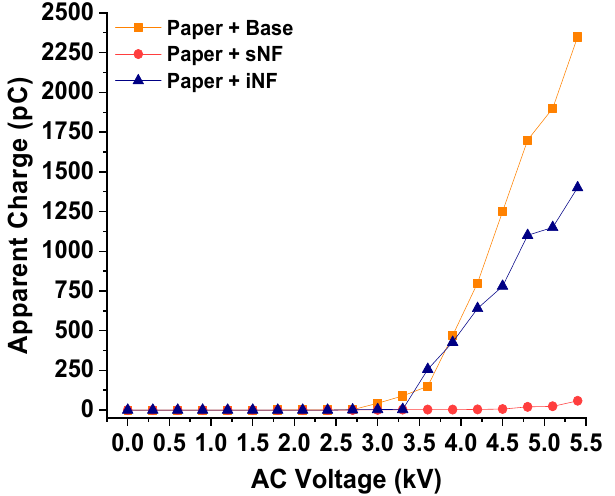
Figure 10. Change of the apparent charge as a function of the applied voltage for the three samples under investigation. Table 7. PDIV and apparent charge at the PDIV.